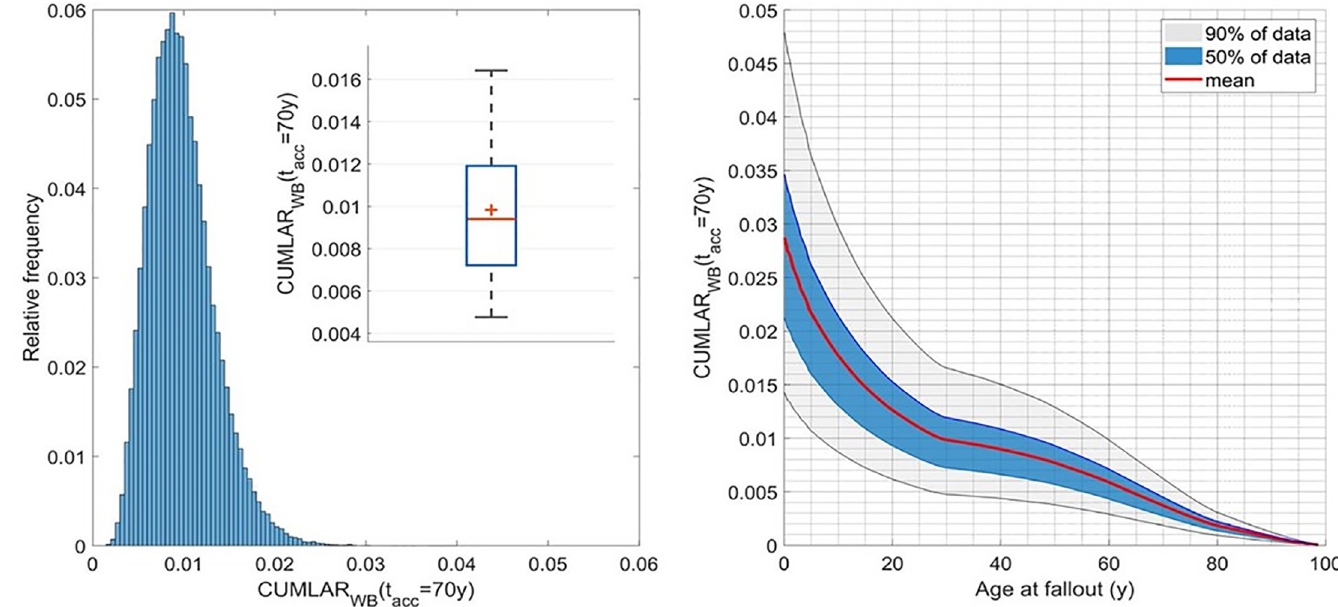
Fig 5. Left: Histogram plot of CUMLAR WB ( t acc = 70 y, A tot , loc = A tot , reg = 1 MBq m -2 ) estimates for adult males (30 y at fallout). Total of 100 kMC runs; results are binned to 5 × 10 − 4 width bins. In the box plot inset, a red cross represents mean value, the horizontal red line is median value, blue box comprises 50% of data, and whiskers extend from 5 th to 95 th percentile. Right: Cumulative lifetime probability, CUMLAR ( t m -2 137 Cs. Grey shaded area comprises 90% of data (from 5 th to 95 th percentile), blue area comprises 50% of data, and red line represents mean value. 10 000 MC runs for each age point.